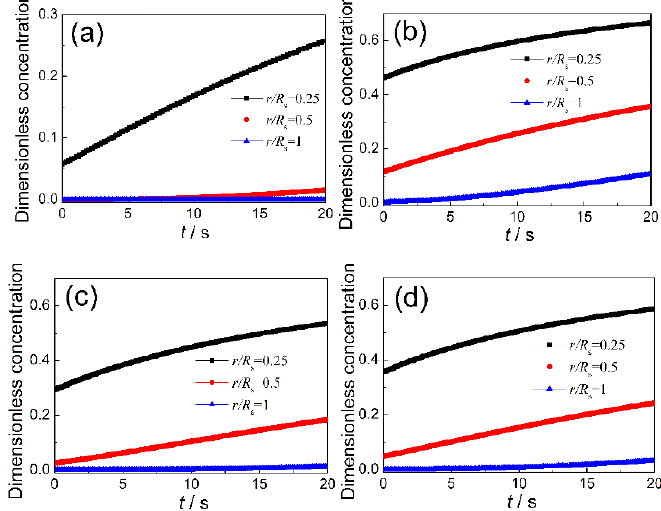
Figure 8. Concentration profiles of target gas at different radial positions of porous sensing layer. ( a ) ( a ) Sample CT0; ( b ) Sample CT1; ( c ) Sample CT2; ( d ) Sample CT3. Sample CT0; ( b ) Sample CT1; ( c ) Sample CT2; ( d ) Sample CT3.